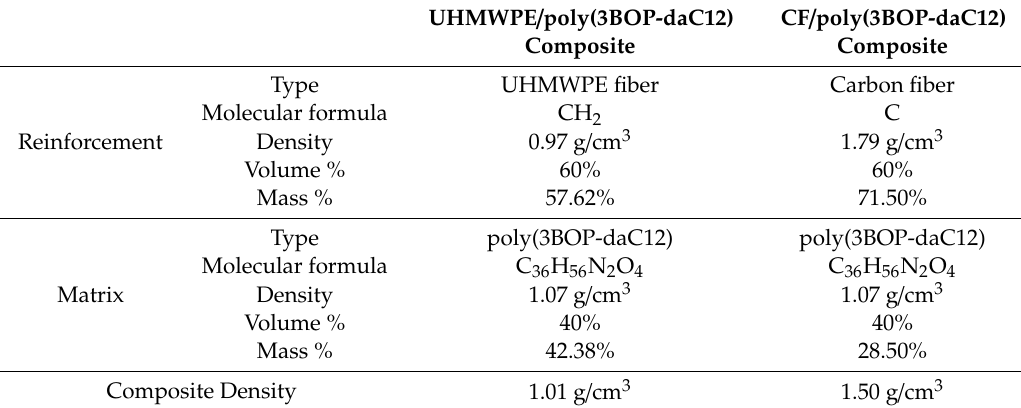
Table 7. Properties used to define OLTARIS composite material